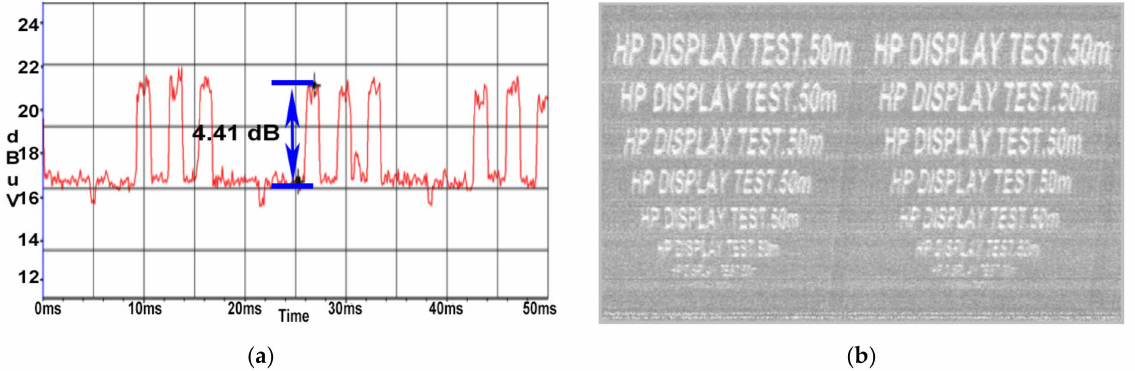
Figure 19. HP display: ( a ) SNR measured at a distance of 50 m; ( b ) image recovered at a distance of 50